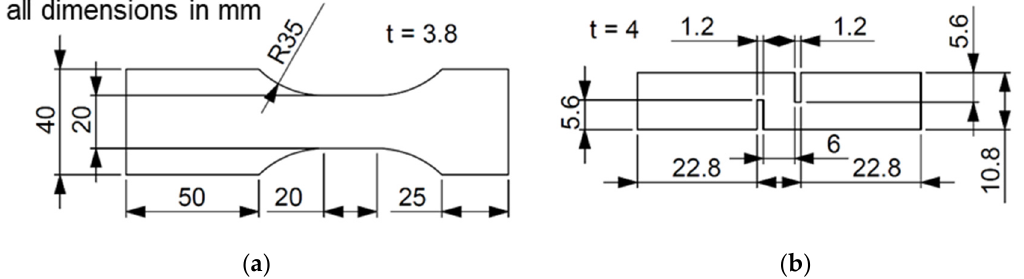
Figure 3. Specimen geometry for: ( a ) tensile tests and; ( b ) shear tests.